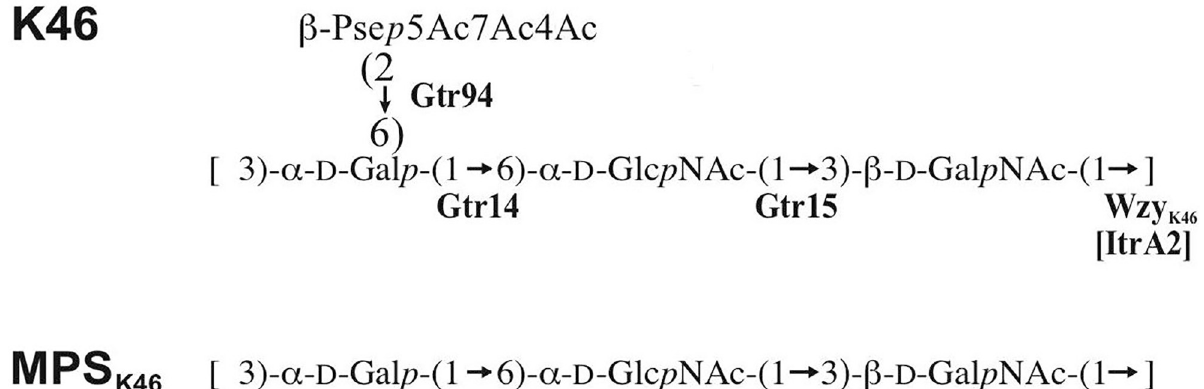
Fig 2. Structures of the capsular polysaccharides CPS K46 and the corresponding modified polysaccharide MPS K46 from A . baumannii NIPH 329.